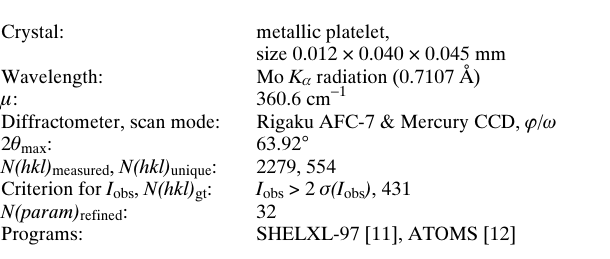
Table 2. Atomic coordinates and displacement parameters (in Å 2 ) . Site Occ.